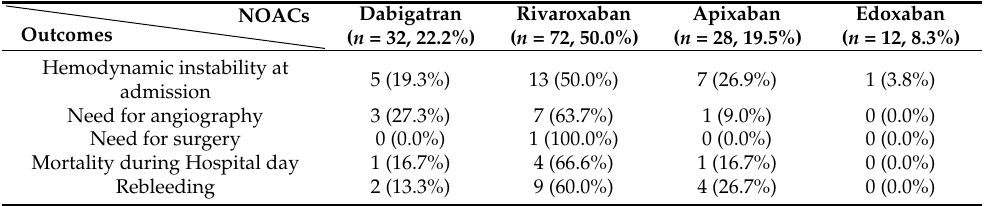
Table 5. The clinical outcomes in the patients associated with different